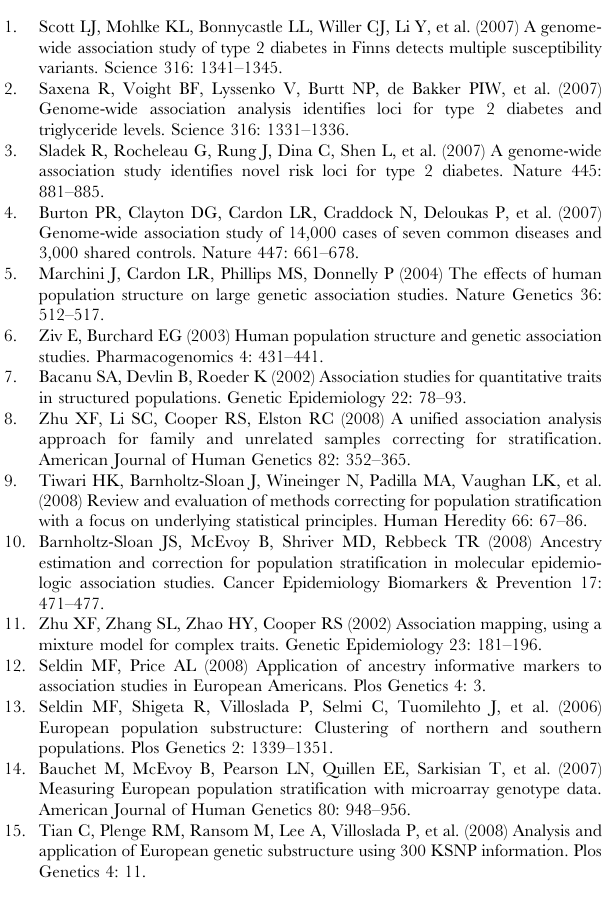
Figure S3 Scores for PCs 1 and 3 of GWAS PCA across the 4 sites. TOR, TBO, NCO and MAYO individuals are highlighted in blue in the respective